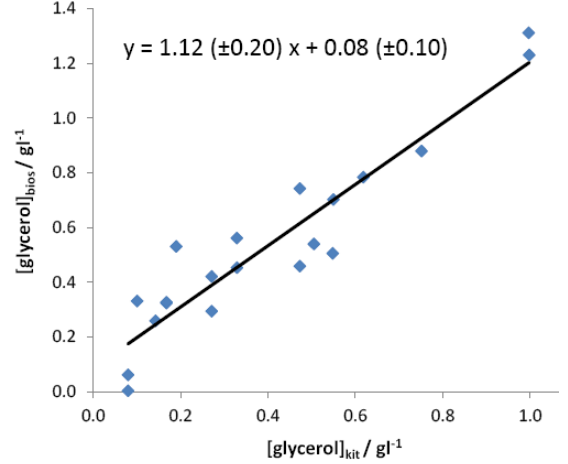
Figure 5. Correlation plot between the concentration of glycerol estimated with the enzymatic kit and the developed automated instrument; grapes of different variety and geographic origin have been reported. Confidence limits (α = 0.05) for slope and intercept are within brackets; r 2 =